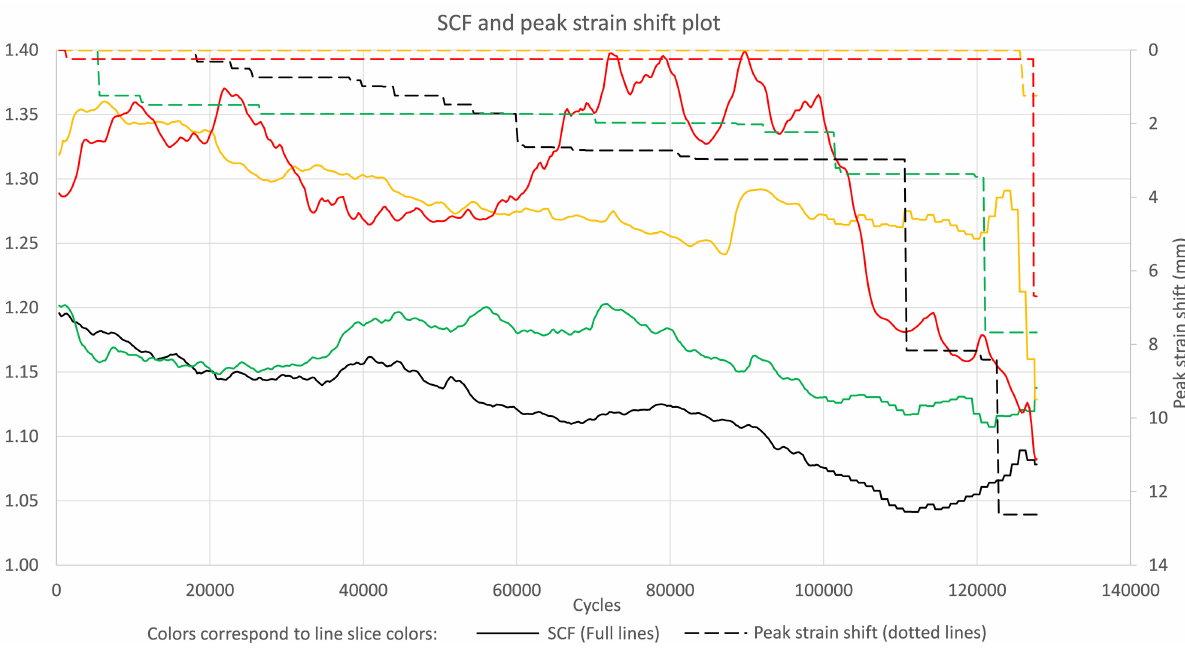
Figure 9: SCF (Maximum strain/average strain) over line slices with the peak strain shift. As can be seen, the SCF is proportional to the redistribution and is steadily falling and lower for the areas with the most redistribution, black and green.